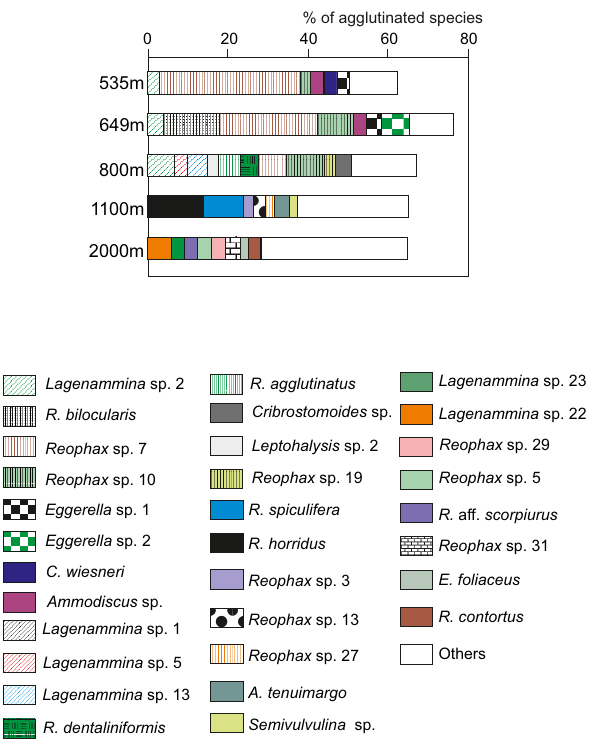
Figure 4. Relative abundances of “live” foraminiferal species in the >150µm fraction of the top 1cm layer at each station. (a) Agglu- tinated assemblage. (b) Calcareous assemblage. In each case, only the dominant species (>2% at each station) are represented individ-